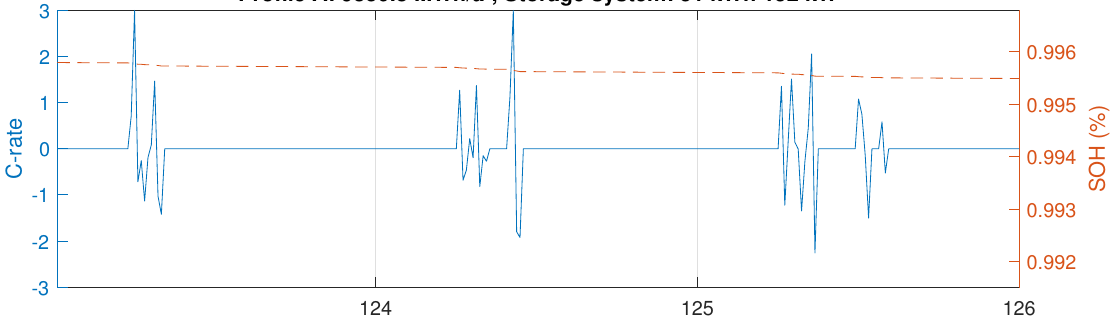
Figure 10. Battery power profile analysis for a three-day period and resulting state of health